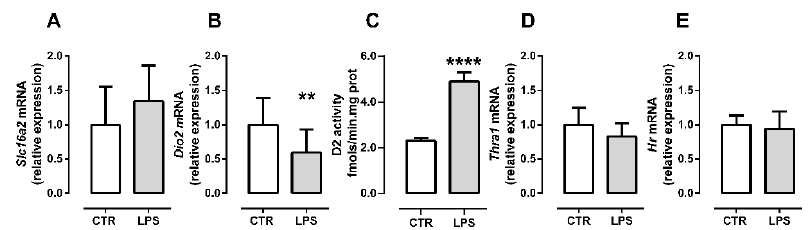
Figure 3. LPS alters TH metabolism in C2C12 myoblasts during initial differentiation. Expression Slc16a2 ( A ), Thra1 ( B ), Dio2 ( C ), D2 activity ( D ), and expression of the TH responsive-gene Hr ( E ) in C2C12 myoblast culture at 24 h post differentiation induction. The white bar represents the control group (CTR), and the gray bar represents the LPS group (LPS, 10 ng/mL). Data are expressed as mean ± SD of at least eight independent experiments in ( A , B , D , E ) and five independent experiments in C . The data normal distribution was confirmed by D’Agostino and Pearson omnibus test; the parametric Student’s t-test was applied. ** p < 0.01, **** p < 0.0001.